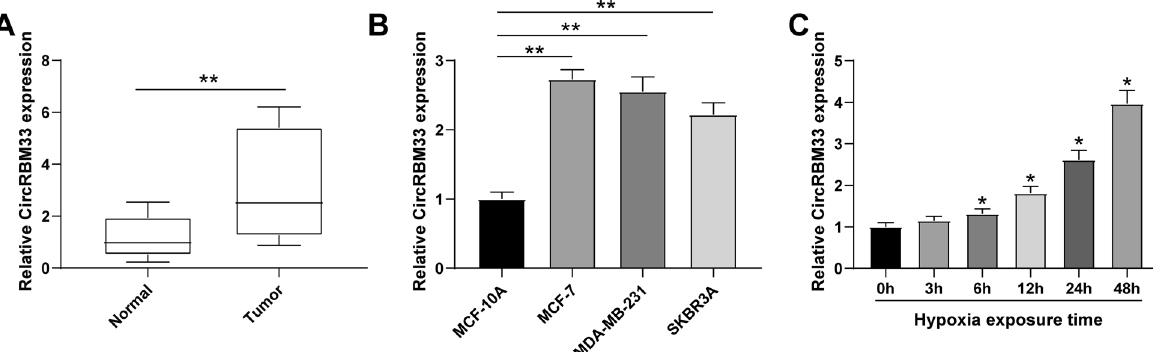
Fig. 1 CircRBM33 is upregulated in BCa tissues and hypoxia-induced BCa cells. A CircRBM33 was upregulated in BCa tissues; B CircRBM33 was upregulated in BCa cells (Compared with MCF-10A cells, circRBM33 expression was 1.7 times higher in MCF-7 cells); C CircRBM33 was upregulated in hypoxia-induced MCF-7 cells; ** P < 0.01; * P < 0.05 compared with the 0 h group. Data were expressed in the form of mean ± standard deviation (Repetitions = 3). The comparison between two groups was performed by t test, that among multiple groups was by one- way ANOVA, and pairwise comparison was by Tukey ’ s